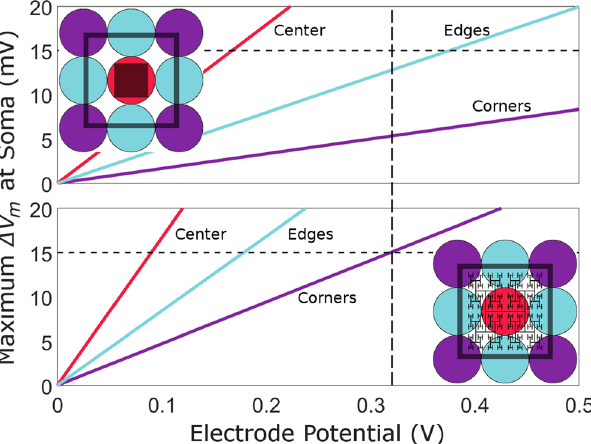
Figure 5. Maximum Δ V m at the soma plotted against electrode voltage for the 9 bipolar neurons (1 center neuron, red; 4 edge neurons, blue; and 4 corner neurons, purple) above square (top) and fractal (bottom) inner electrodes (each located within an outer electrode of width 20 μ m). The vertical dashed line